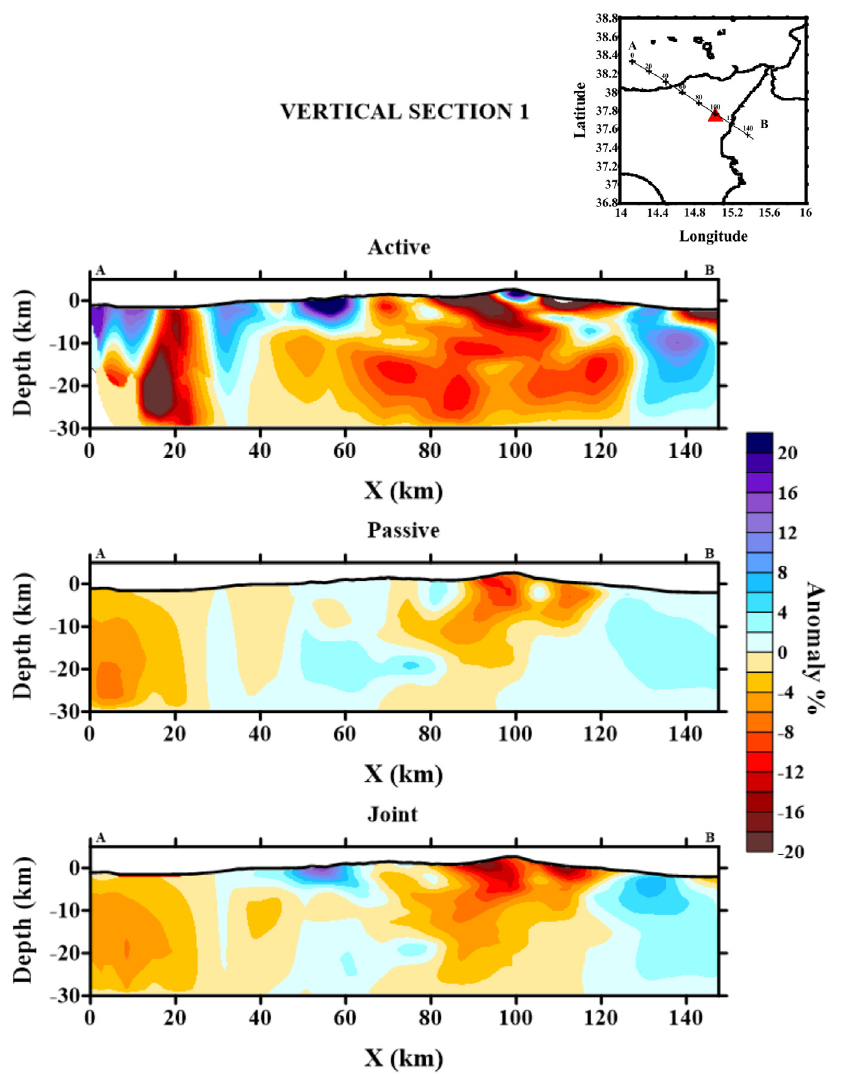
Figure 9. Vertical section of the real data inversion of the TOMO-ETNA dataset using a 6-km-spacing grid: active dataset (upper frame); pas- sive dataset (middle frame) and joint dataset (lower frame). Red triangle shows the location of Mt.